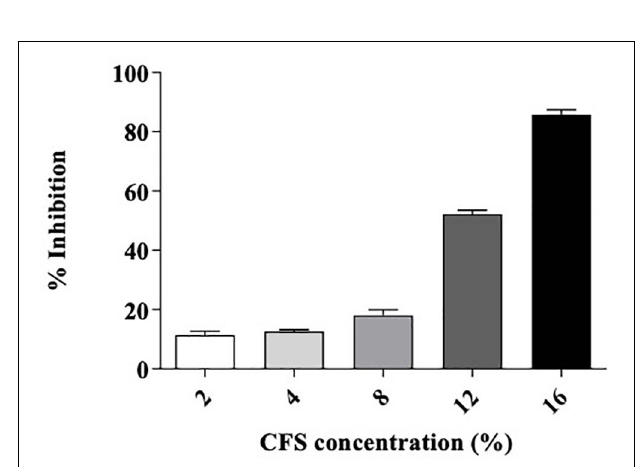
FIGURE 7 | Minimum fungicidal concentration of L. brevis MYSN105-CFS against F. verticillioides by microdilution method. Data shown are mean ± SE of triplicate values of three independent